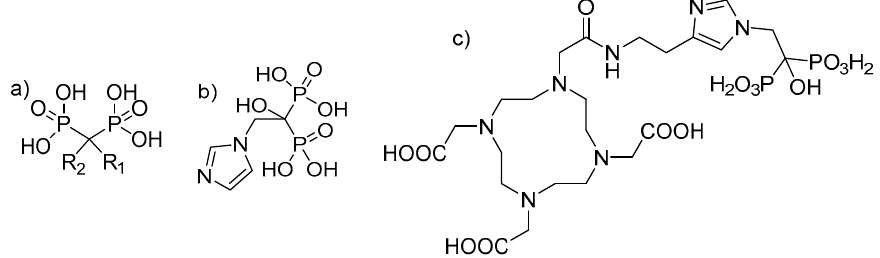
Figure 1. ( a ) Chemical backbone of bisphosphonates. ( b ) Chemical structure of zoledronate with R 1 : OH and R 2 : imidazol-1-ylethyliden. ( c ) Chemical structure of 1,4,7,10-tetraazacyclododecane-1,4,7,10- tetraacetic acid-conjugated zoledronic acid (DOTA-ZOL).